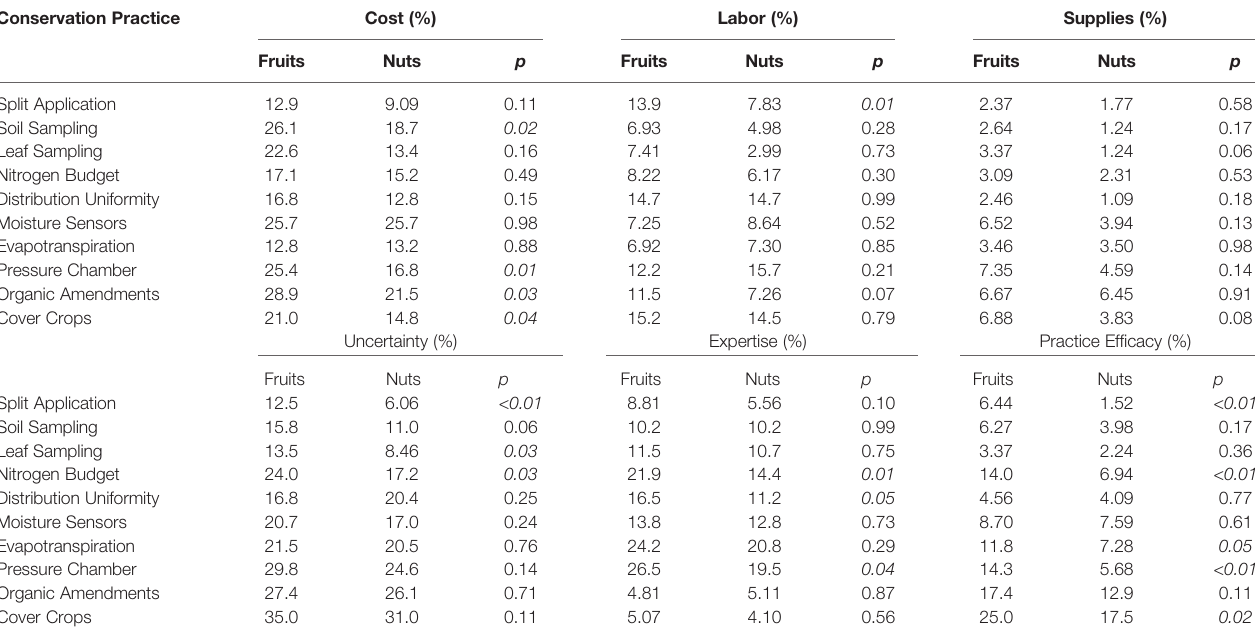
Conservation Practice Cost (%) Labor (%) Supplies (%) Fruits Nuts p Fruits Split